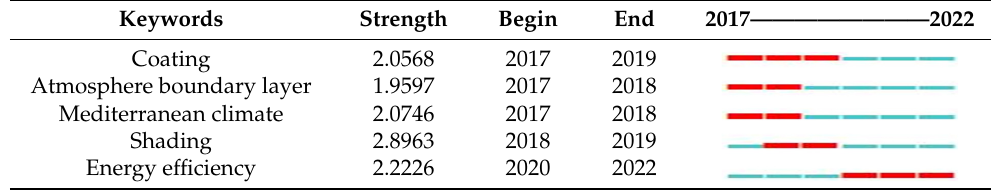
Table 3. Keywords highlighting strength and timing of urban microclimate research in 2017–2022.